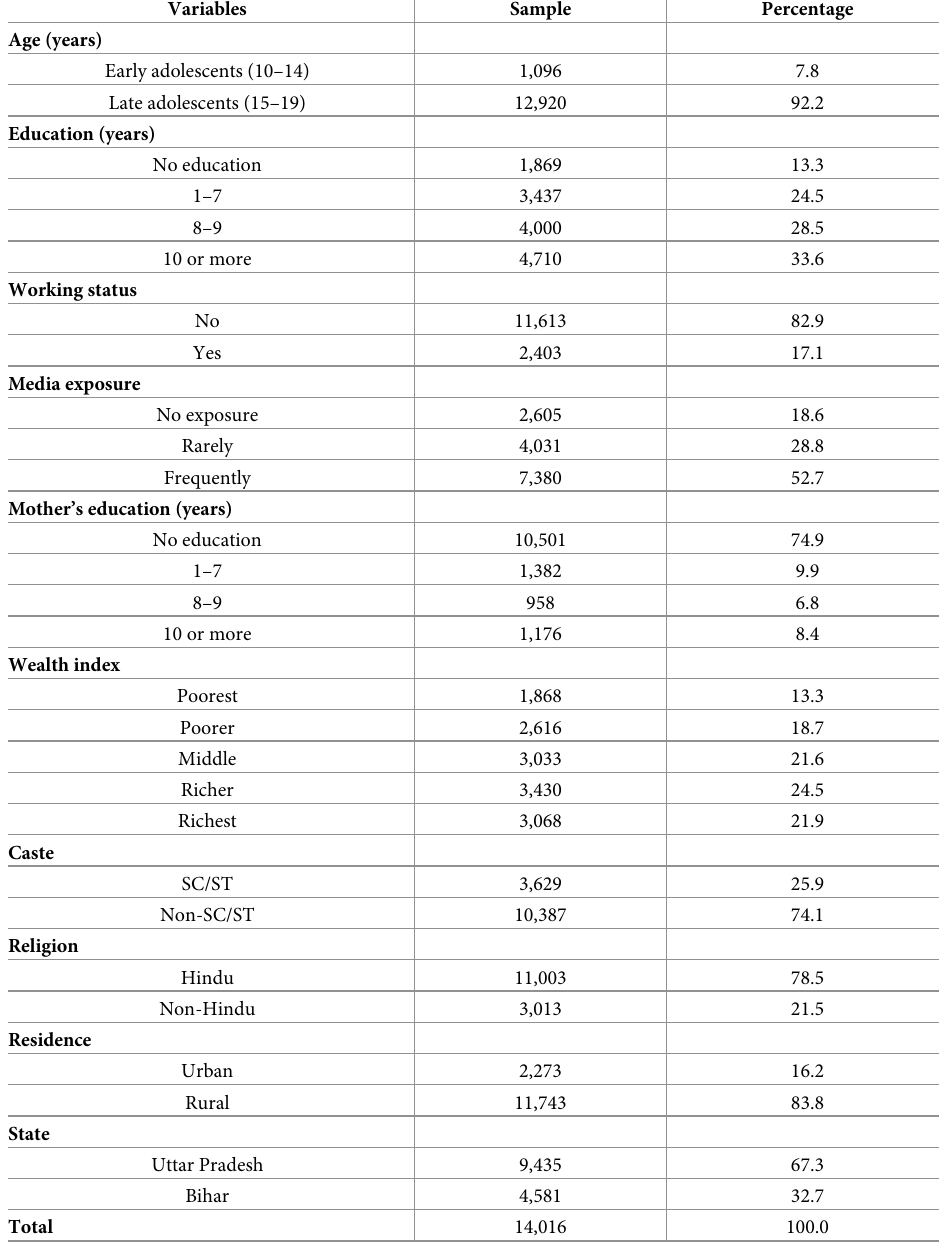
Table 1. Socio-demographic profile of adolescent girls.